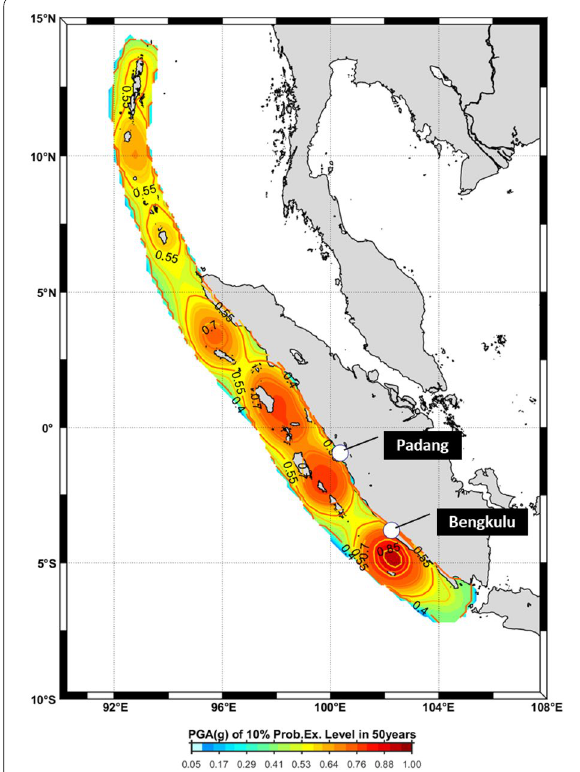
Fig. 4 Seismic hazard maps expressed as the PGA of 10% of exceedance probability in 50 years. The total exceedance probability is calculated on the basis of selected sources within a radius distance of about 100 km along the Sumatran Subduction Zone for events with a magnitude range of 6.0 to 9.0. In calculating PGA, the parameters of influence are the changes in the magnitude and distance of source which are based on the GMPE of ZH97 and AT06 and the calculated mean